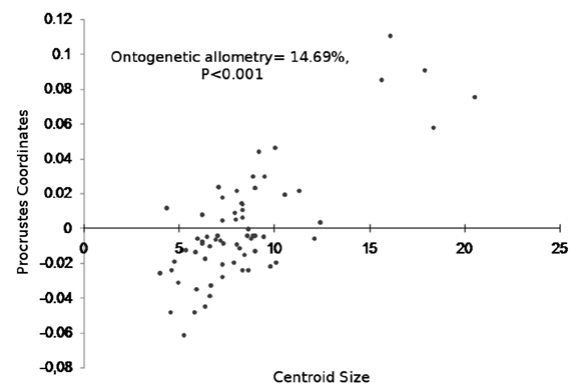
Fig. 6. – Regression of the Procrustes coordinates and centroid size for estimation of ontogenetic allometry during larval development of Myxodes